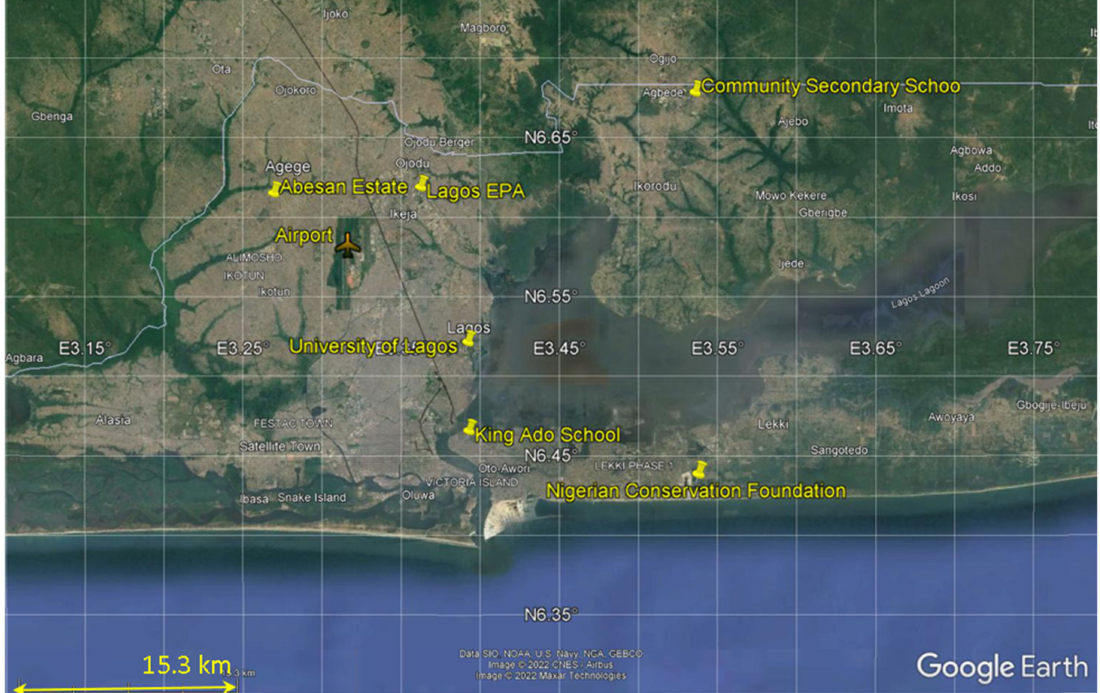
Figure 1. Map of Lagos metropolitan area with monitoring station locations (airport shown as reference location). The central body of water is the Lagos lagoon. The entry from the Gulf of Guinea is located at the bottom center of the map. The seaport and lagoon entry are bottom center. A map of the Niger Delta region with Lagos is included in Figure